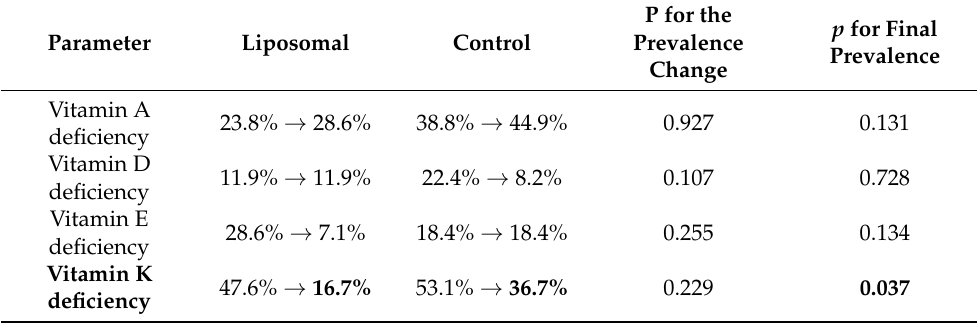
Figure 2. Vitamin A, D, E, and K status in pancreatic-insufficient CF patients before and after supplementation with the novel liposomal formulation or standard forms. Table 5. The frequencies of vitamin A, D, E, and K deficiency at the start and → at the end of the trial. The changes in the frequency of insufficiency were compared using the Mann-Whitney U test with the continuity correction (statistically significant differences are presented in bold). The final frequencies of deficiencies were compared using the Fisher’s exact